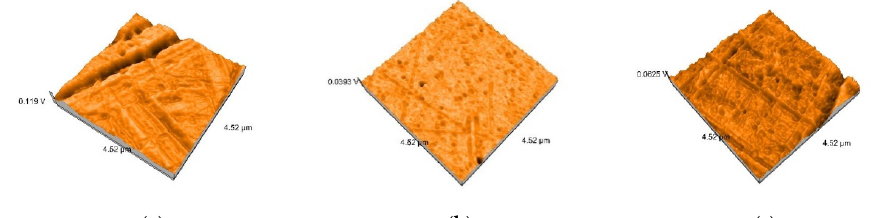
Figure 11. 3D AFM images of the thermoformed samples: ( a ) S; ( b ) D; ( c ) B.